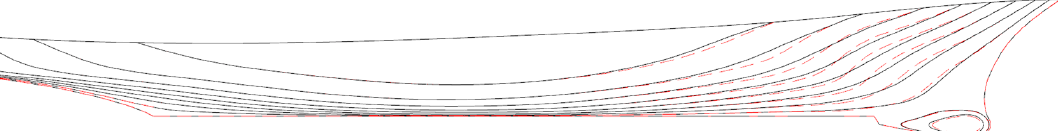
Figure 22. Comparison of profile views of dimensionality reduction optimized and original hull forms. Table 10. Optimization results of dimensionality reduction